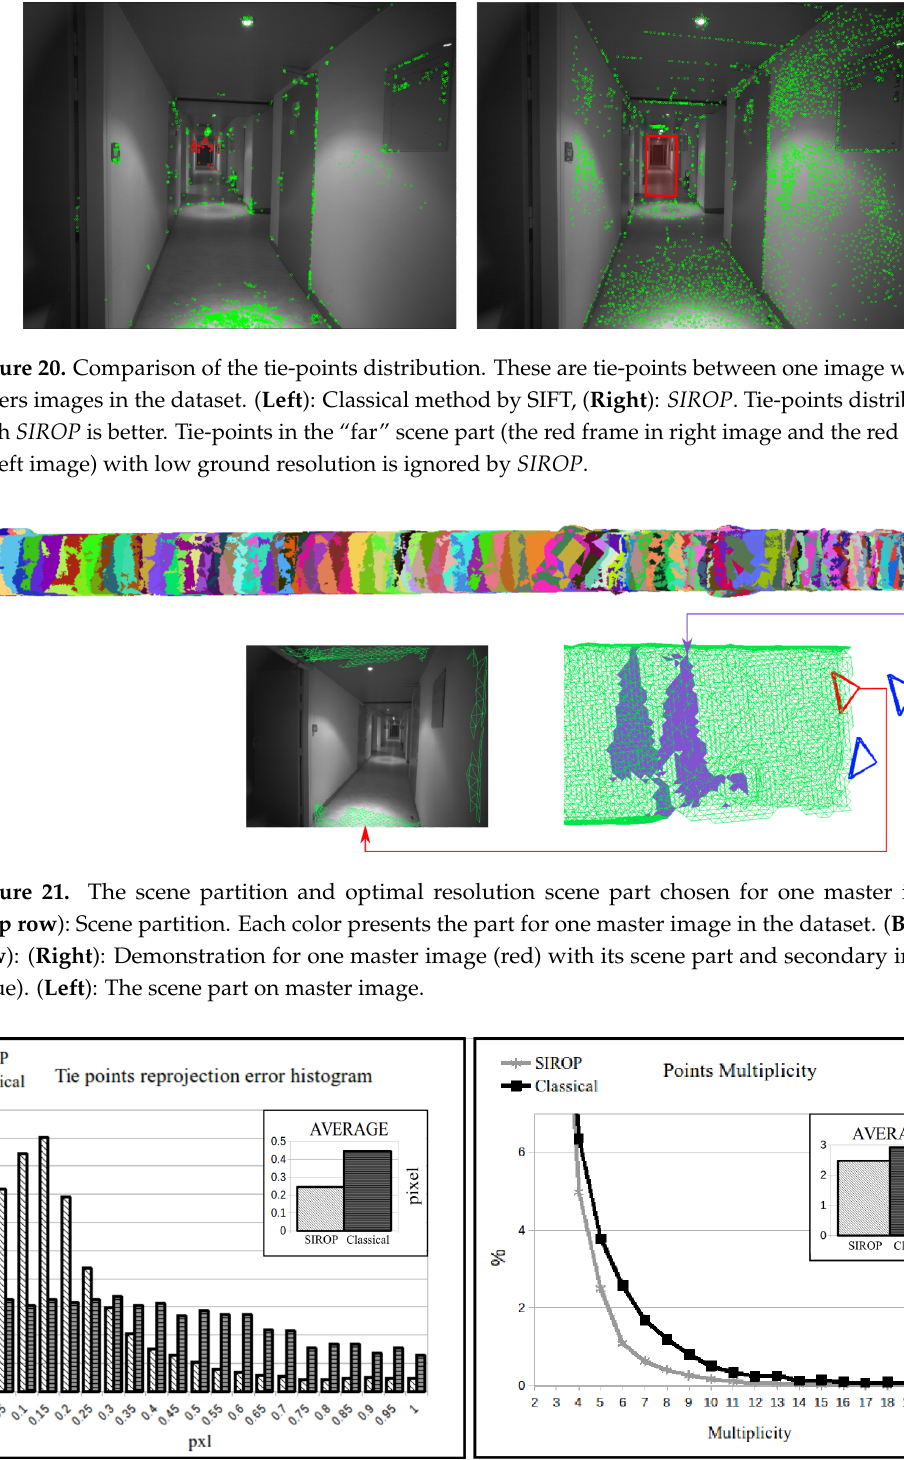
Figure 22. Comparison of the statistics of tie-points properties between two processing methods. SIROP produces tie-points with smaller re-projection error but less multiplicity in this specific case. ( Left ): re-projection error histogram. ( Right ):